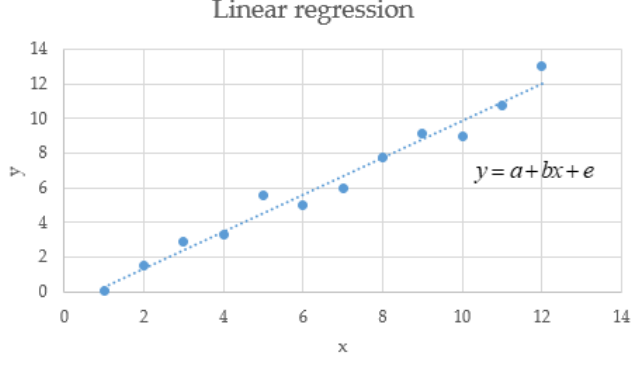
Figure 12. Linear regression.